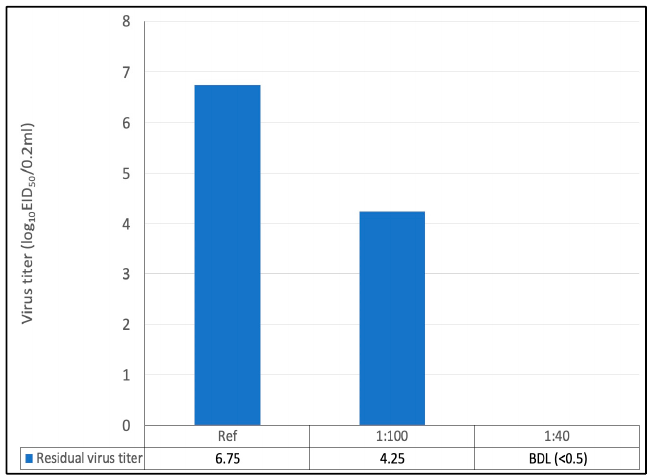
Figure 7. Antiviral test results.